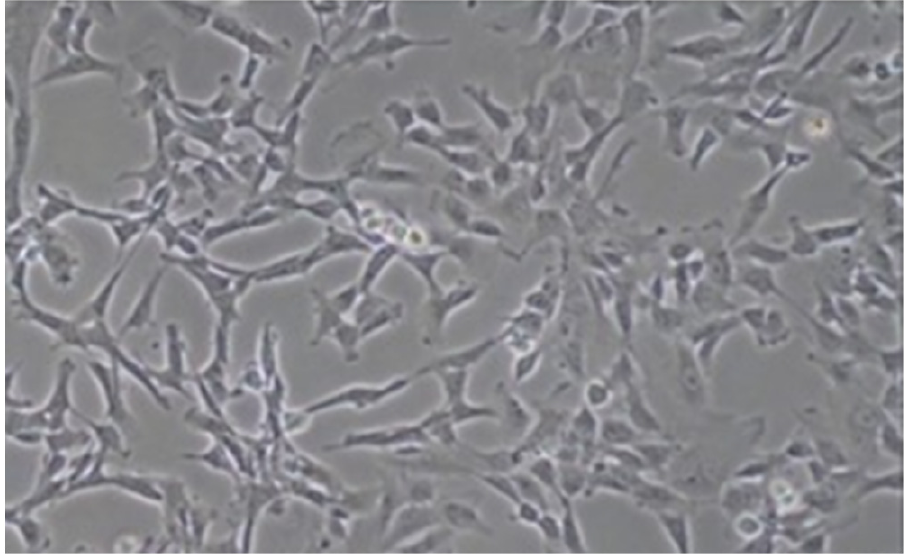
Figure 1. Third passage of the AFSC cell culture. They appear with a fibroblastoid-like shape (10× magnification with a phase-contrast microscope).